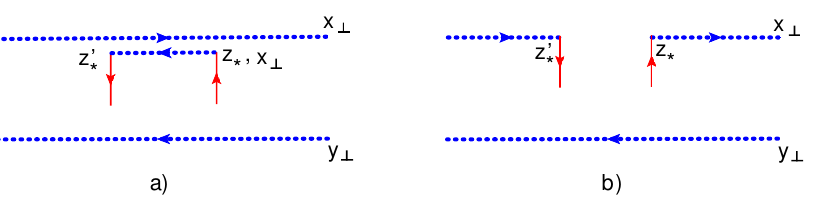
Figure 4 . Figure a) represents the operators Tr { U x U † represents operators Tr { ˜ Q 1 x U †